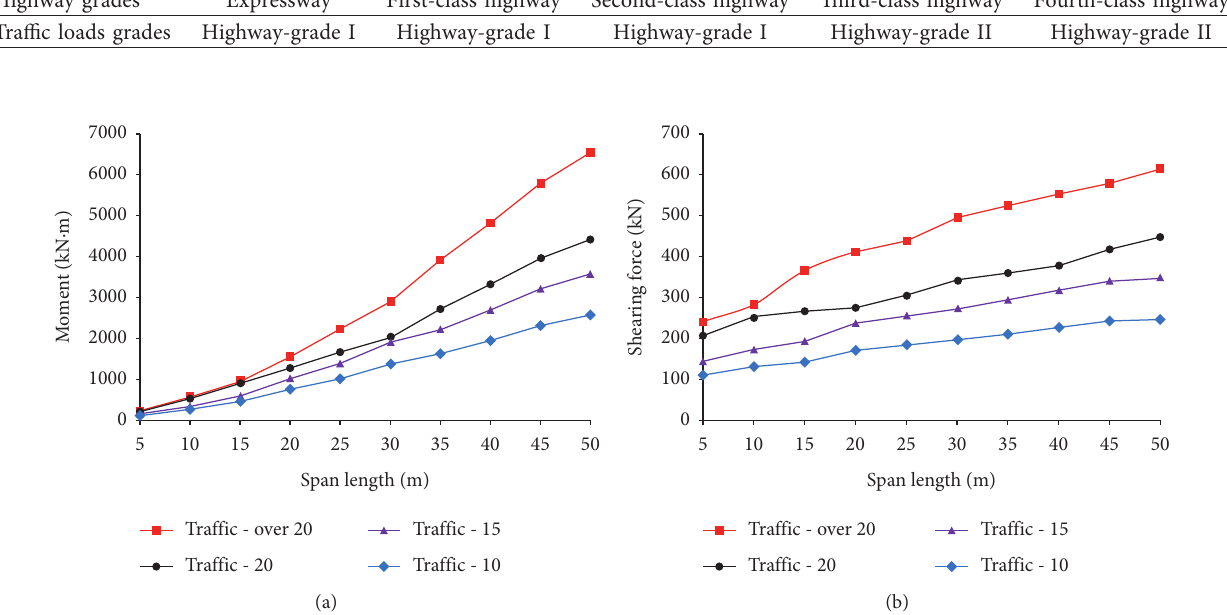
Table 3: Traffic load grades of the bridges for different highway grades in JTG D60-2015. Highway grades